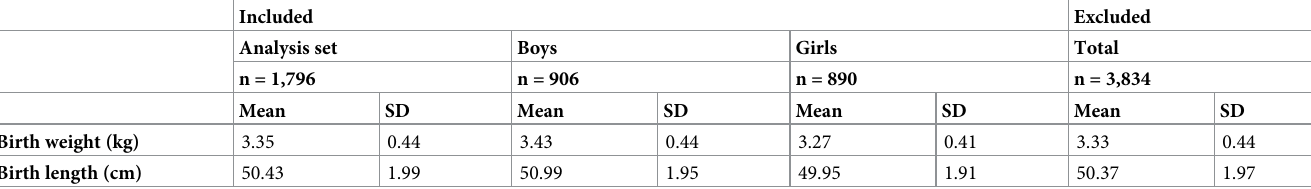
Table 2. Mean and standard deviation for birth length and birth weight for children in the Czech ELSPAC cohort. Included